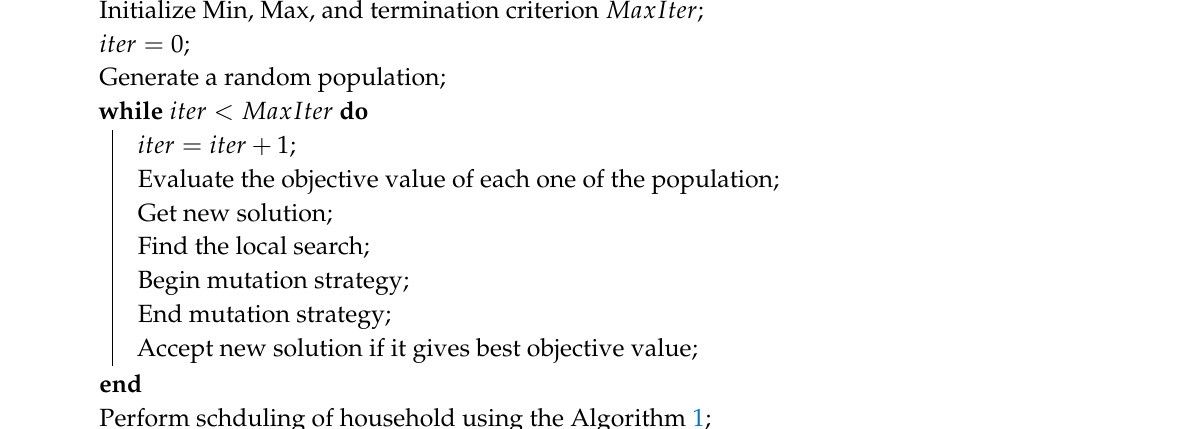
Algorithm 2: Proposed Jaya based HEMS